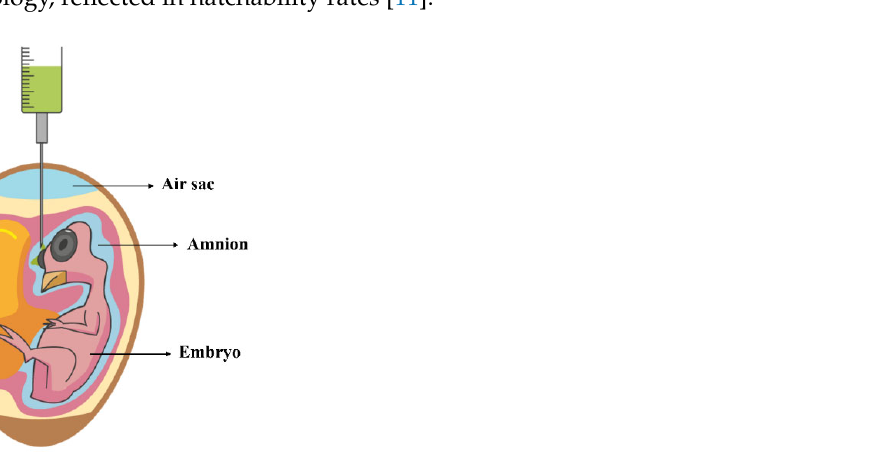
Figure 1. Delivery of substances into the amniotic fluid during embryonic development.